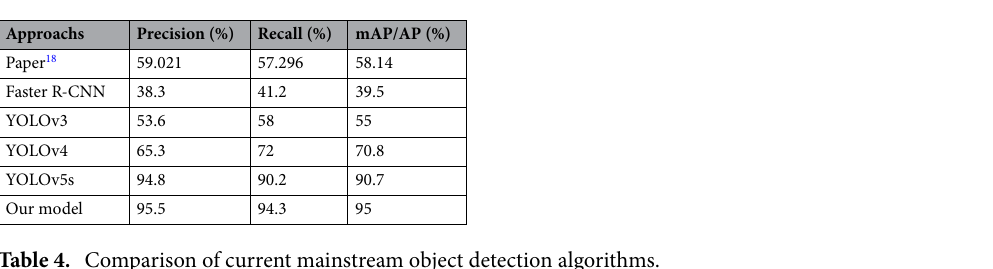
Table 4. Comparison of current mainstream object detection